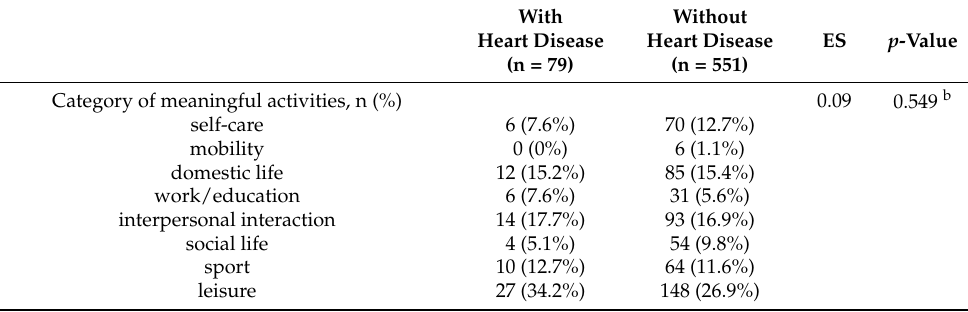
Table 4. Meaningful Activities in Those with and Without Heart